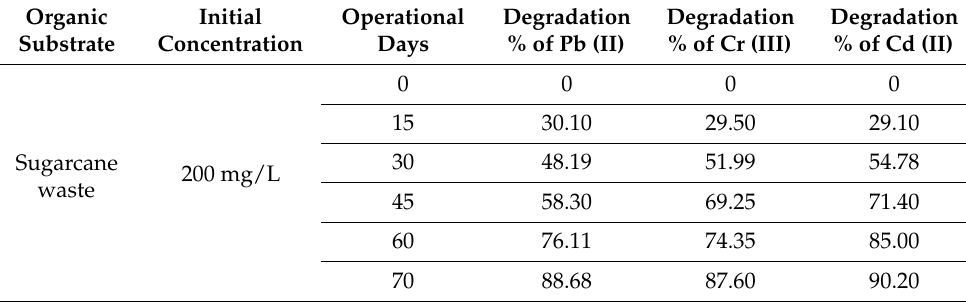
Table 3. Degradation efficiency of metals in